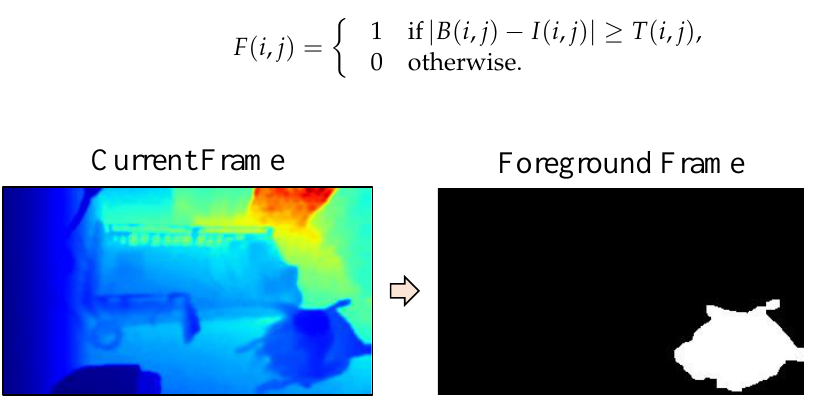
Foreground FrameCurrent Frame